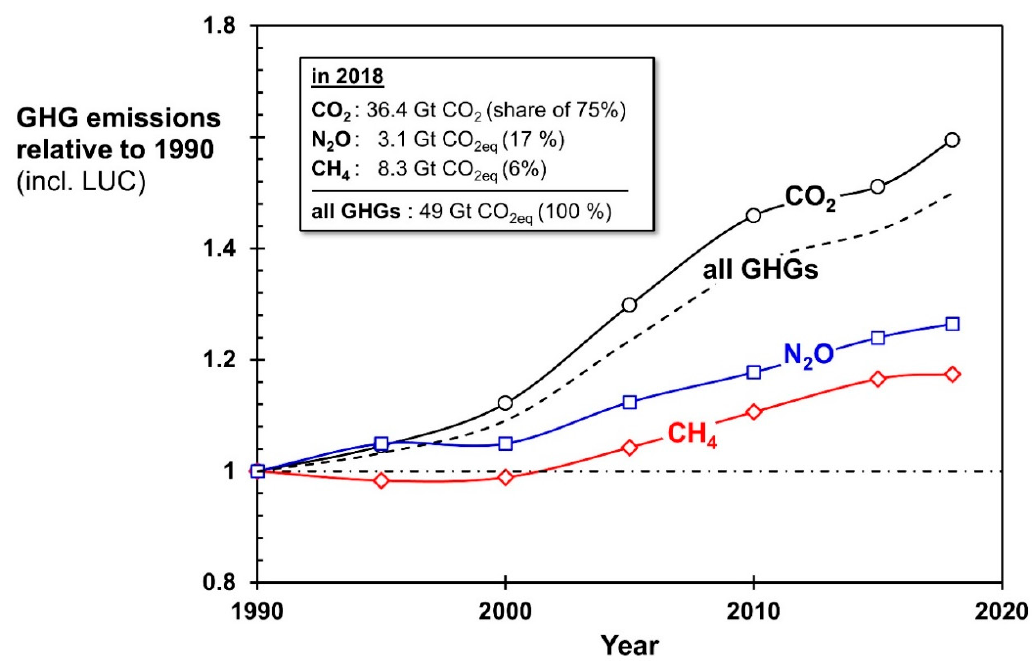
Figure 1. Global emissions of CO 2 , CH 4 , N 2 O, and of all GHGs relative to the year 1990 including land use change (LUC) (data from [2]). Fluorinated greenhouse gases (F-gases) are not shown, but emissions have strongly increased from 0.3 Gt CO 2eq in 1990 to 1.3 Gt CO 2eq in 2018 (2% on total GHG). Table 1. GHG emissions per capita (pc), in total, relative to gross domestic product in selected countries in 1990/2016. [2,3], human development index in 2017 [4], and population in 1990/2020. GHG Emissions (incl. F-Gases and LUC) HDI Country Gt CO 2eq